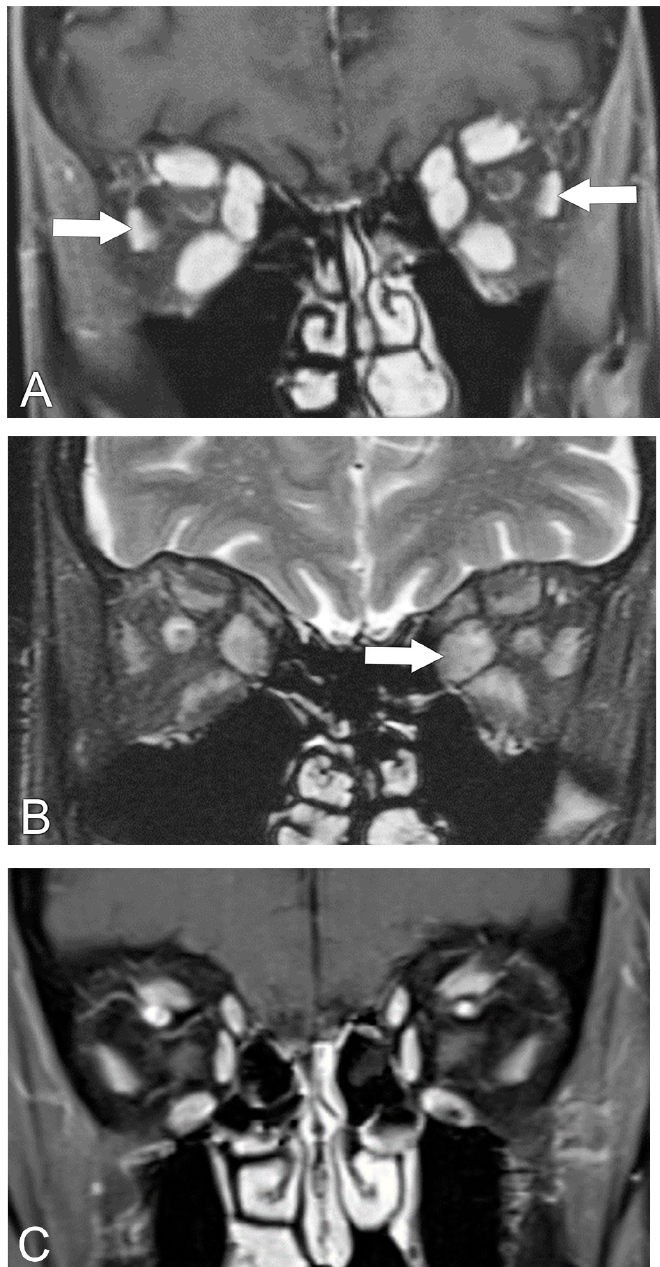
Figure 2. Graves’ eye disease, MRI. ( A ) Coronal T1 post-contrast MRI sequence shows enlargement of bilateral extra-ocular muscles with sparring of the lateral rectus muscles (arrows). ( B ) Coronal T2 MRI sequence shows hyperintense signal signifying edema in the enlarged extraocular muscles (ar- row). ( C ) Coronal T1 post-contrast MRI sequence shows the normal appearance of the extra-ocular muscles.